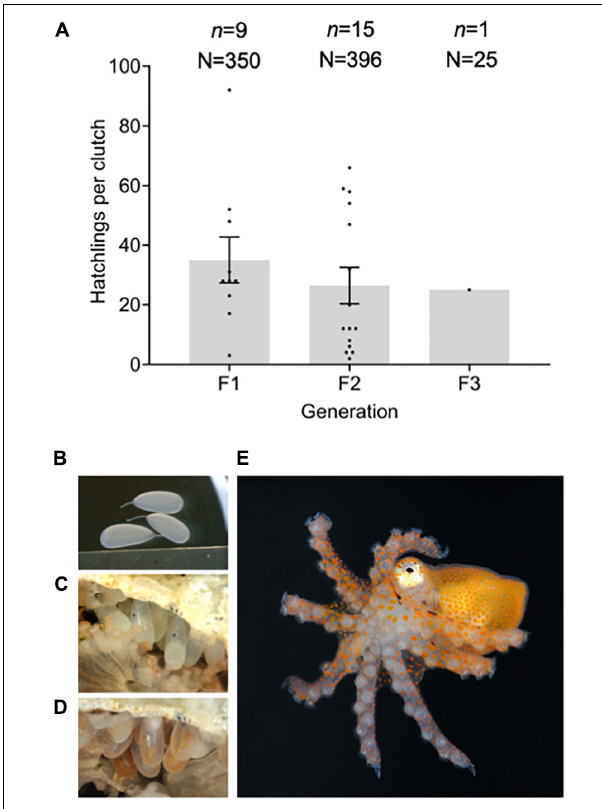
FIGURE 4 | Octopus chierchiae eggs and hatchlings. (A) Hatchlings per clutch by generation. Mean ( ± SEM) hatchlings per clutch is reported by bars and number of hatchlings for each clutch is reported by black points. A one-way analysis of variance revealed no significant difference between the means of first and second generations ( p > 0.05). The number of hatchlings for the one third-generation clutch is reported. (B) Translucent, freshly deposited eggs. (C) Eggs with visible eyespots and yolk sac at approximately 17 days post-laying. (D) Eggs with visible chromatophores at approximately 30 days post-laying. (E) O. chierchiae hatchling with bright orange pigmentation; F1, first generation; F2, second generation; F3, third generation; n, number of clutches; N, total number of hatchlings; SEM, standard error of the mean.